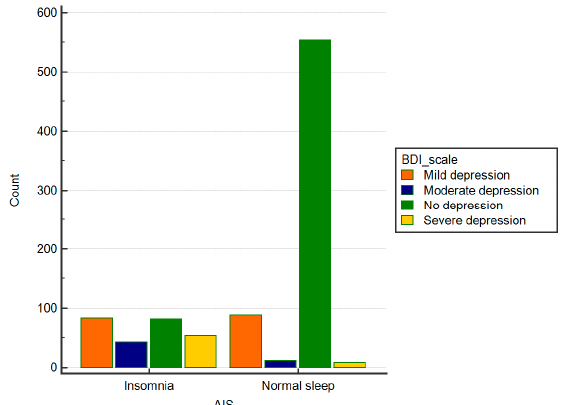
Figure 3. Percentage distribution of the severity of depressive symptoms according to the BDI-II classification in groups with and without insomnia according to the AIS scale.